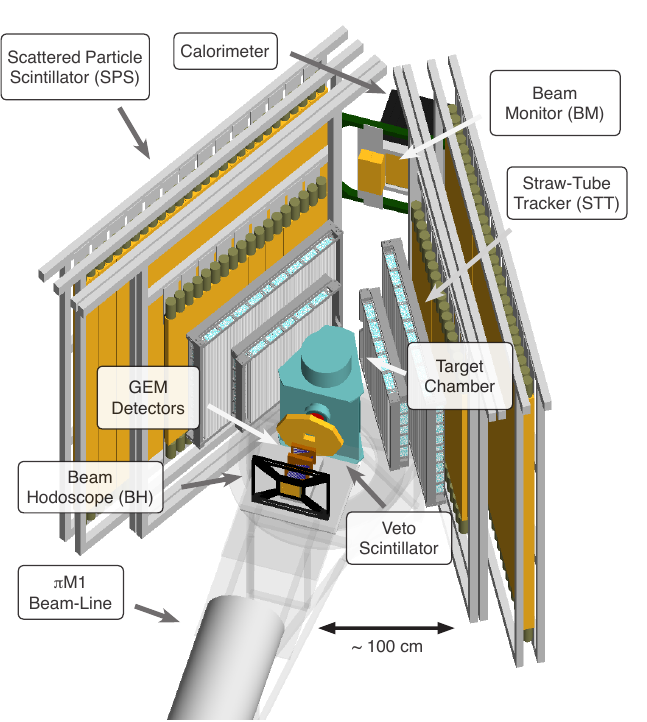
Figure 9. The experimental apparatus of the MUSE experiment. Figure credit: Steffen